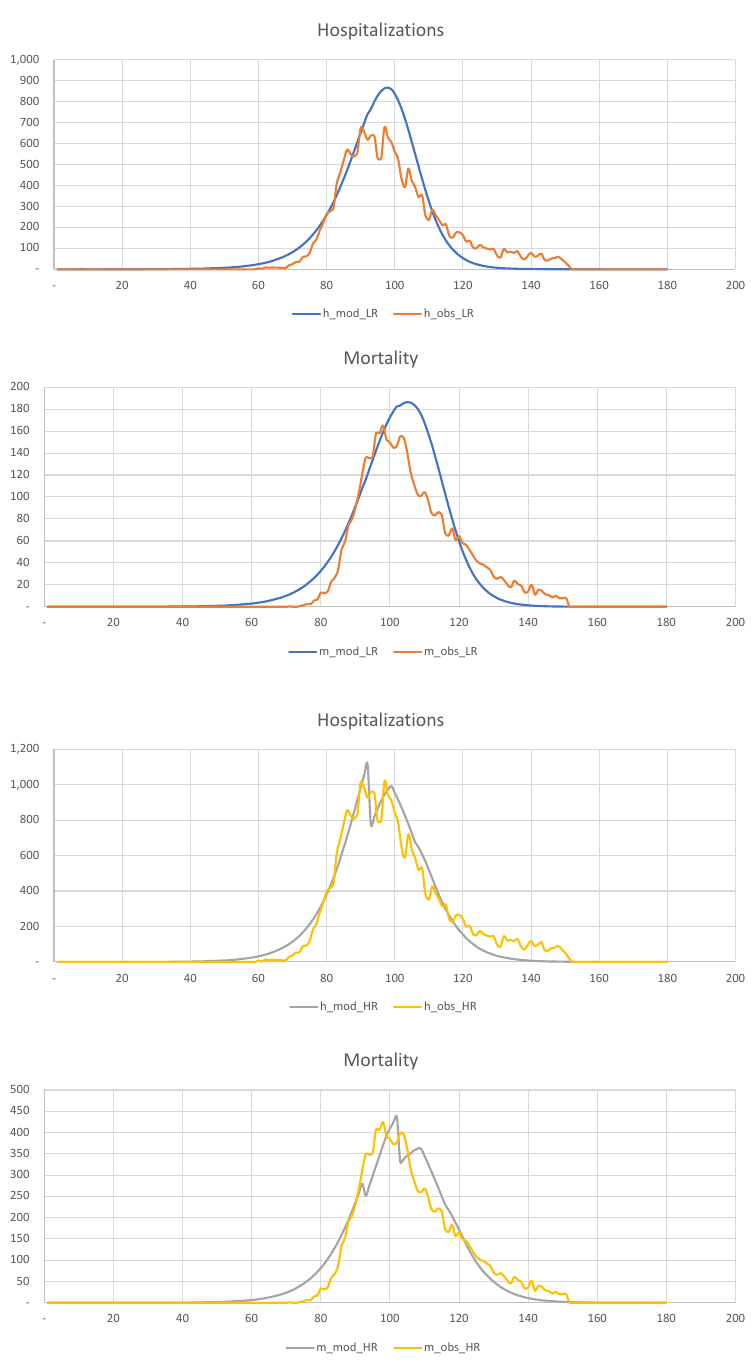
Figure 22. Hospitalization and mortality assuming that there is no quarantine for the low-risk population and there is quarantine for the high-risk